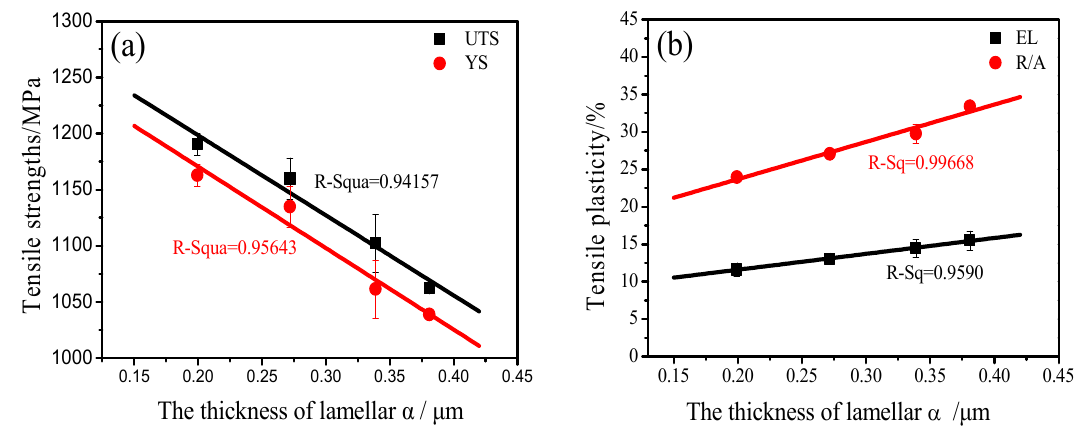
Figure 7. The relation between tensile property and the thickness of lamellar α on Ti17 alloy: ( a ) ultimate tensile strength and yield strength, ( b ) elongation and reduction of area.